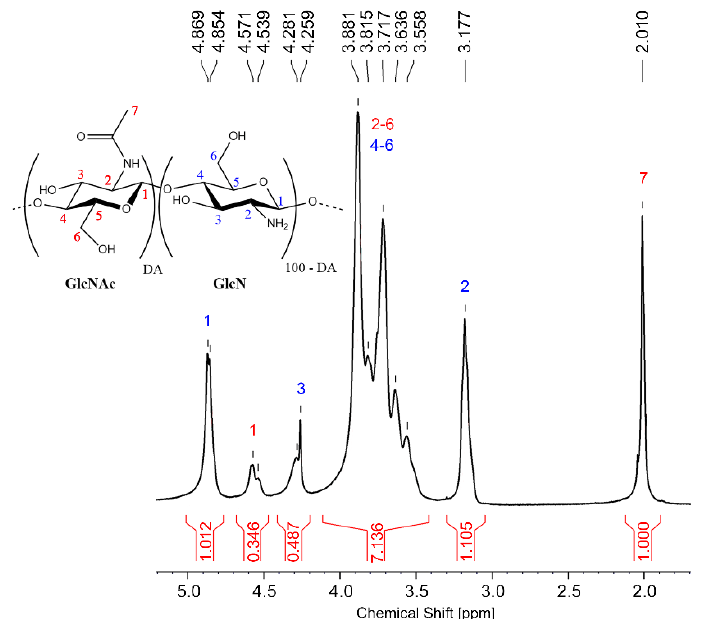
Figure 3. 1 H-NMR spectra of chitosan Q24 in DCl/D 2 O at 70 °C (500 MHz).